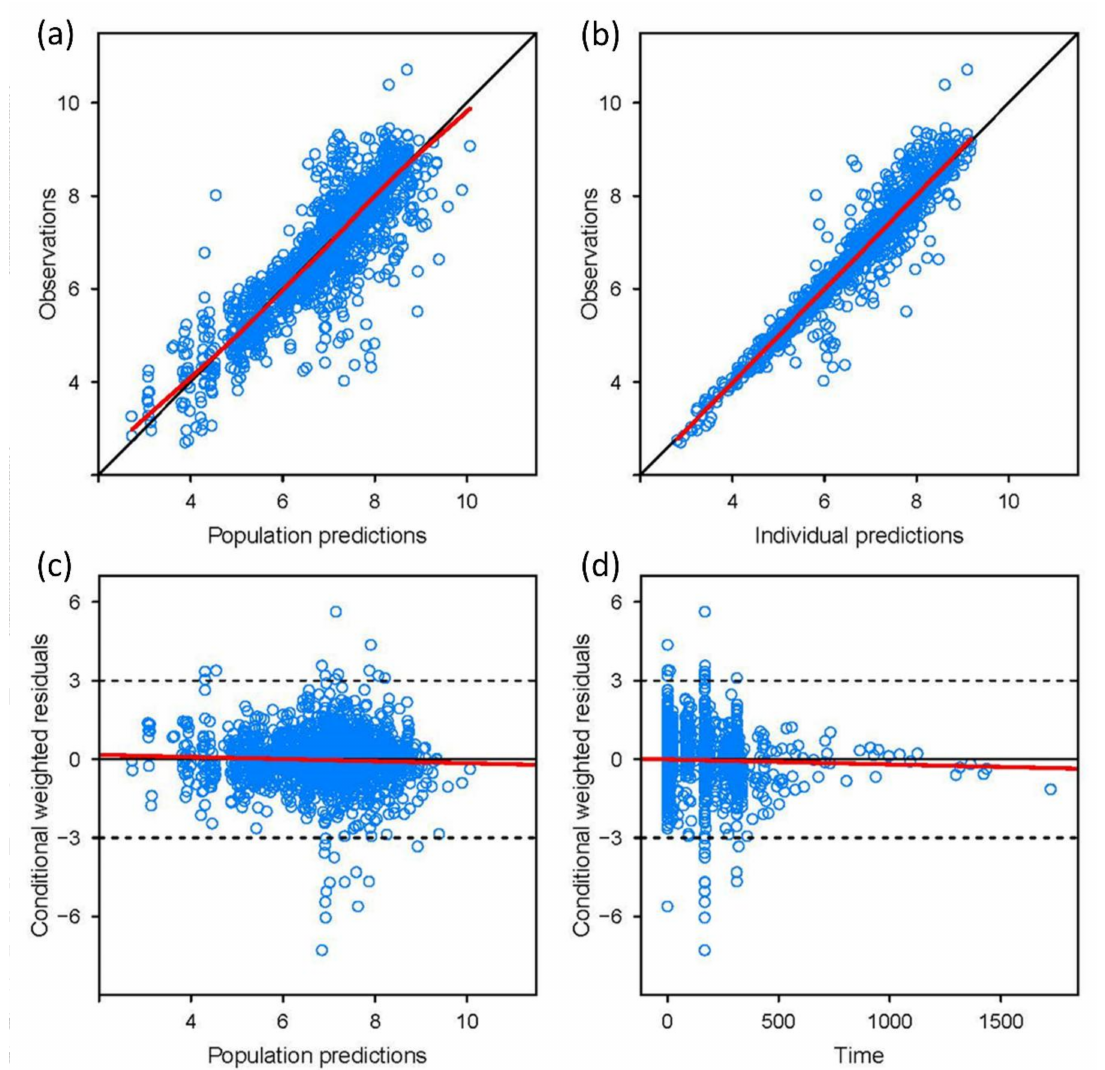
Figure 2. Basic goodness-of-fit plots of final model. ( a ) observations versus population predictions; ( b ) observations versus individual predictions; ( c ) conditional weighted residuals versus population predictions; ( d ) conditional weighted residuals versus